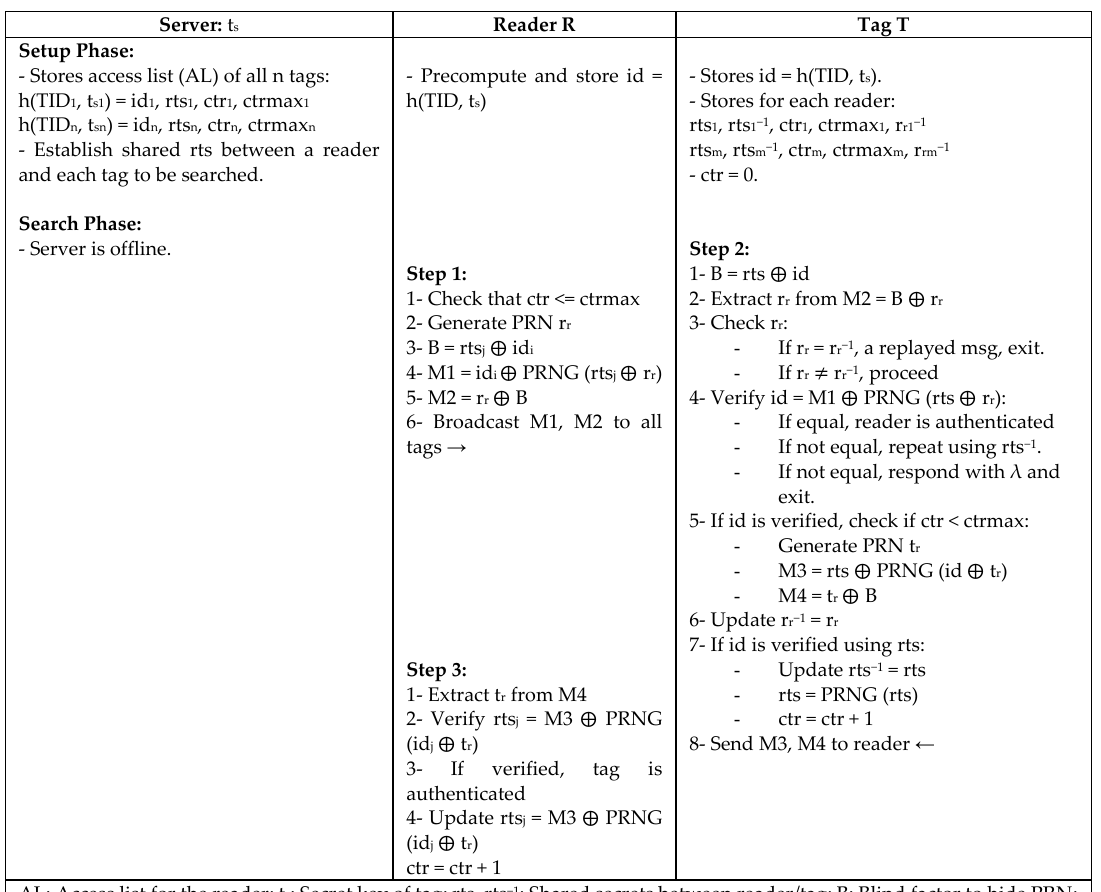
Figure 23. Ultra-Lightweight Serverless Authentication Protocol (STS) by Sundaresan.